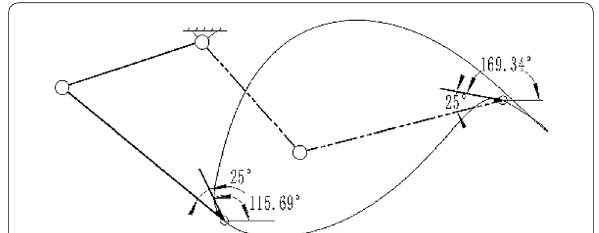
Figure 7 Mechanism after adjusting the rod length parameters